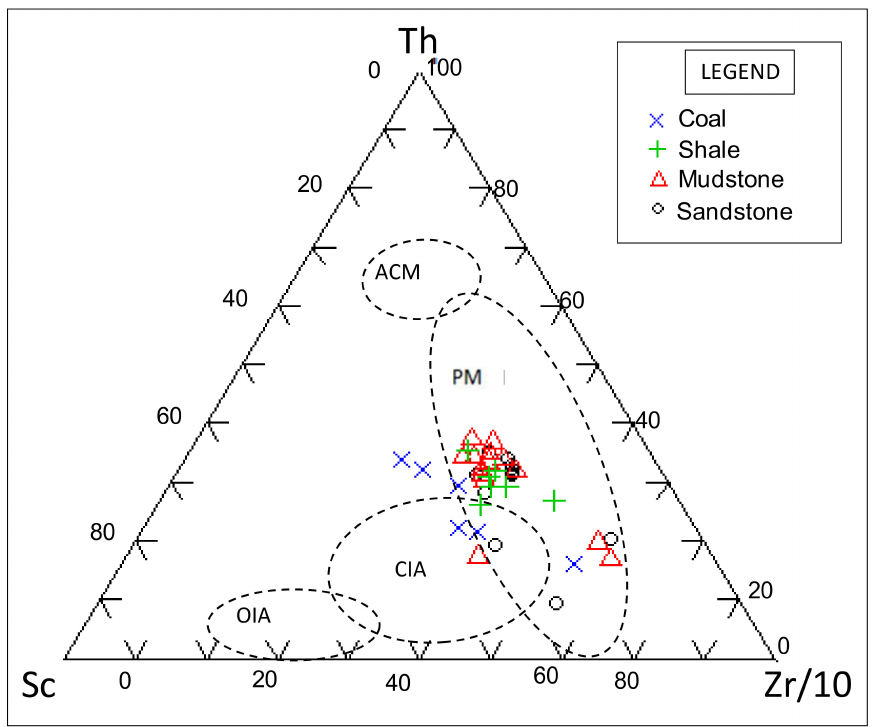
Figure 11. Th-Sc-Zr/10 ternary plot for the studied samples showing tectonic setting (Background field after [6]). Note: PM, ACM, CIA and OIA represent Passive Margin, Active Continental Margin, Continental Island Arc, and Oceanic Island Arc,